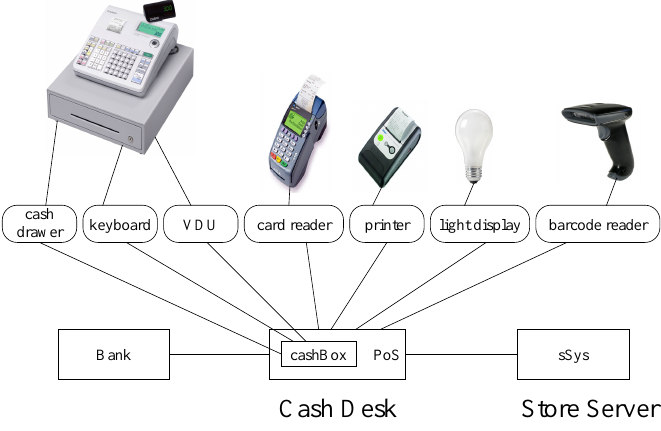
Figure 30. The cash desk system of common component modeling